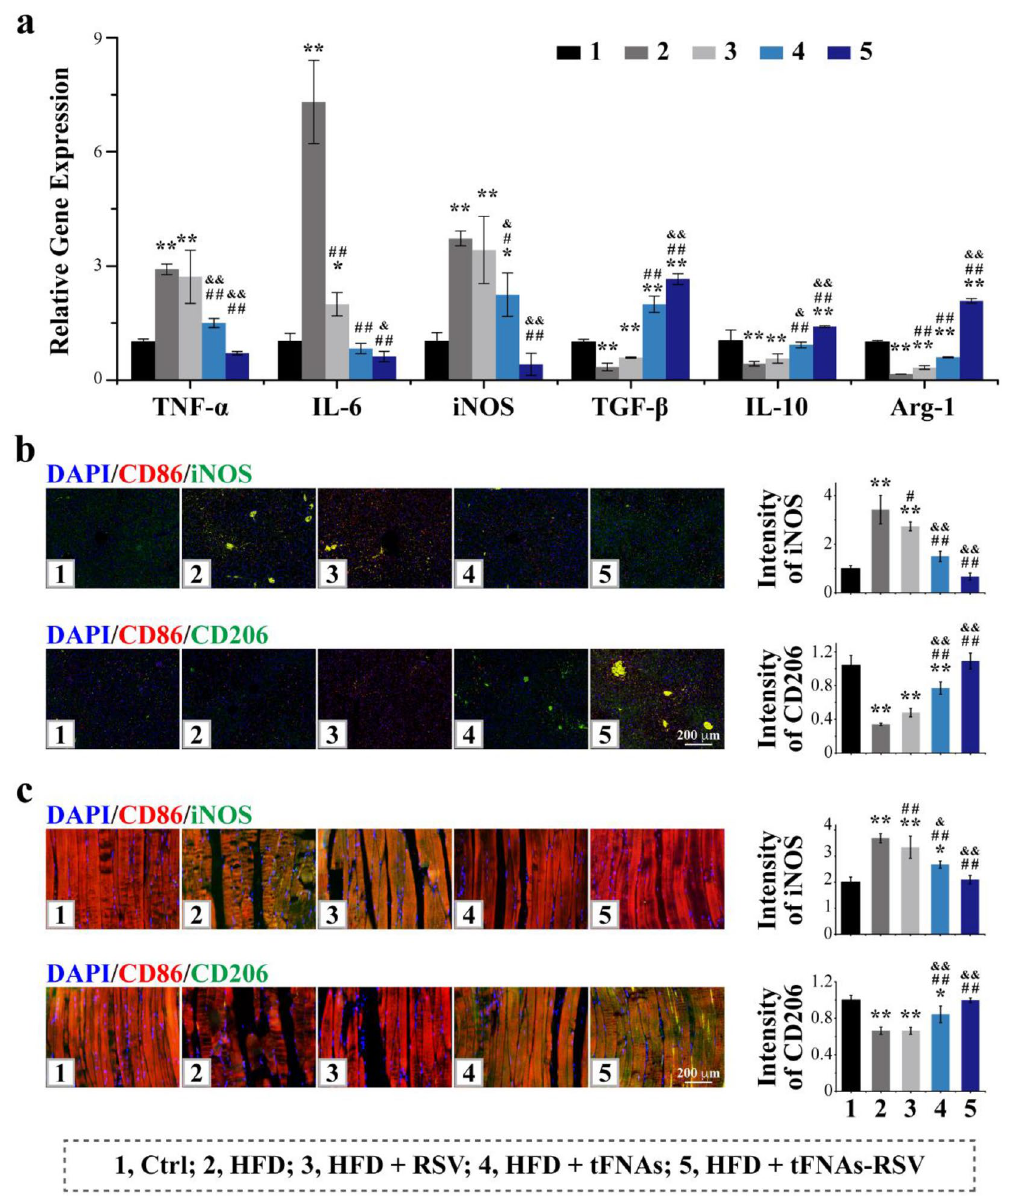
Fig. 4 tFNAs-RSV ameliorate IR in liver and muscle through macrophages polarization. a Quantitative RT-PCR analysis of the expression of TNF-α , IL-6 , iNOS , TGF-β , IL-10 , and Arg-1 in livers of different mice; b Liver tissue immunofluorescence staining of CD68, iNOS, or CD206, and quantitative analysis of the relative fluorescence intensity of iNOS or CD206; c Skeletal muscle tissue immunofluorescence staining of CD68, iNOS, or CD206, and quantitative analysis of the relative fluorescence intensity of iNOS or CD206. Scale bars: 200 μm. Data were performed using one-way analysis of variance (ANOVA) and presented as mean ± SD ( n ≥ 3). Statistical analysis: * Compare with the control group, * P < 0.05, ** P < 0.01; # Compare with the LPS and IFN-γ group, # P < 0.05, ## P < 0.01; & Compare with the control group, & P < 0.05, && P <